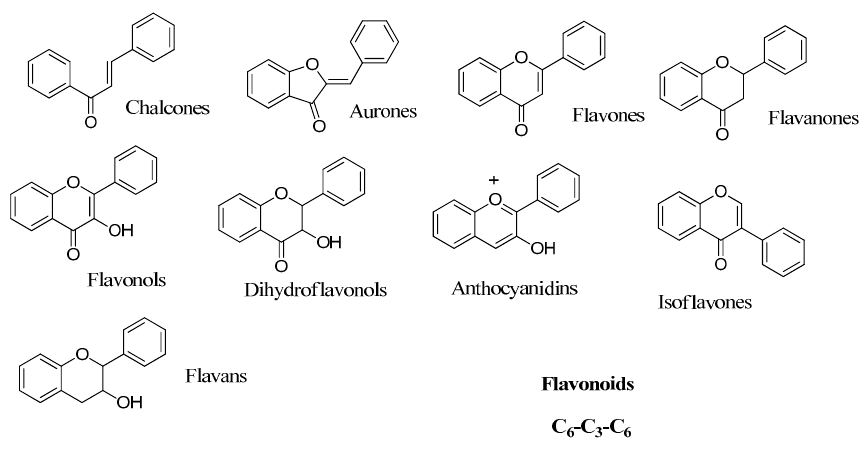
Figure 4. Basic flavonoid structures.